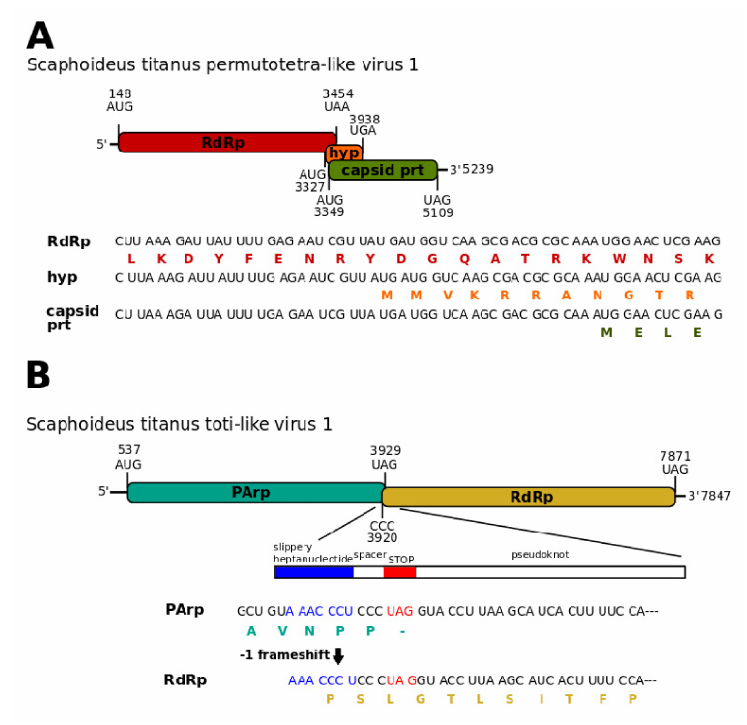
Figure 2. Structures of Scaphoideus titanus permutotetra-like virus 1 and Scaphoideus titanus toti-like virus 1. ( A ) The organization of the genome of Scaphoideus titanus permutotetra-like virus 1; ( B ) the organization of the genomes of Scaphoideus titanus toti-like virus 1 found in the St_IT2, St_FR and St_CH libraries is the same, but the 5 (cid:48) and 3 (cid:48) UTRs show di ff erent lengths. In this figure we specifically illustrated the genome assembled from the St_IT2 library. Boxes represent boundaries of ORFs. RdRp: RNA-dependent RNA polymerase. Hyp: hypothetical protein. Capsid prt: capsid protein. PArp: proline-alanine rich